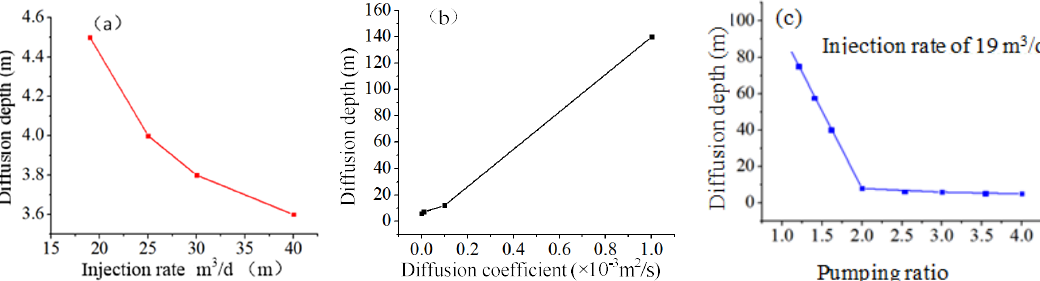
Figure 9. E ff ect of the mining technology on the development of the uranium-bearing solution. Figure 9. Effect of mining technology on the development of the uranium-bearing solution, (a) ( a ) Relationship between injection rate and di ff usion depth; ( b ) Relationship between di ff usion Relationship of injection rate and diffusion depth; (b) Relationship of diffusion coefficient and coe ffi cient and di ff usion depth; ( c ) Relationship between pumping ratio and di ff usion diffusion depth; (c) Relationship of pumping ratio and diffusion depth.